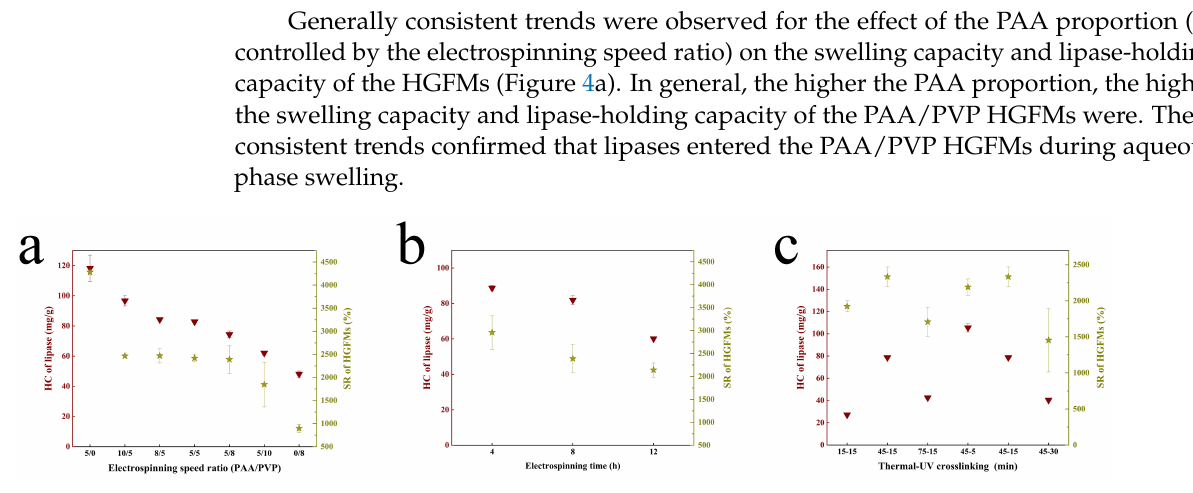
Figure 4. Lipase-holding capacities and swelling ratios of PAA/PVP HGFMs determined under differ- ent experimental conditions. ( a ) Different electrospinning speed ratios. ( b ) Different electrospinning times. ( c ) Different crosslinking